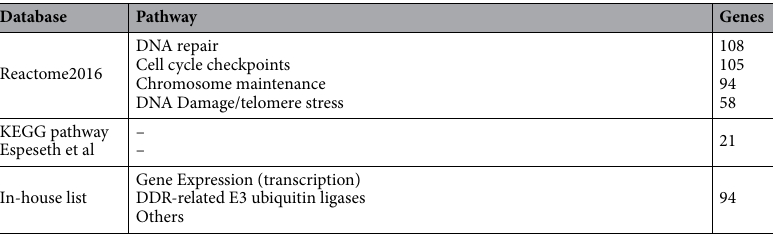
Table 1. Cellular pathways represented in the subgenomic library.